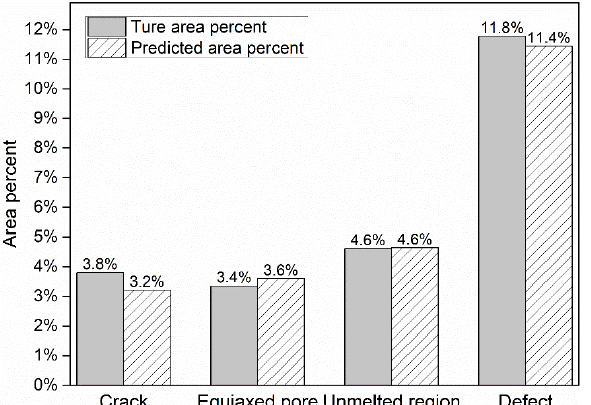
Figure 11. True and predicted area percentages for each class of microstructure in a hypothetical image containing all 57 test images.